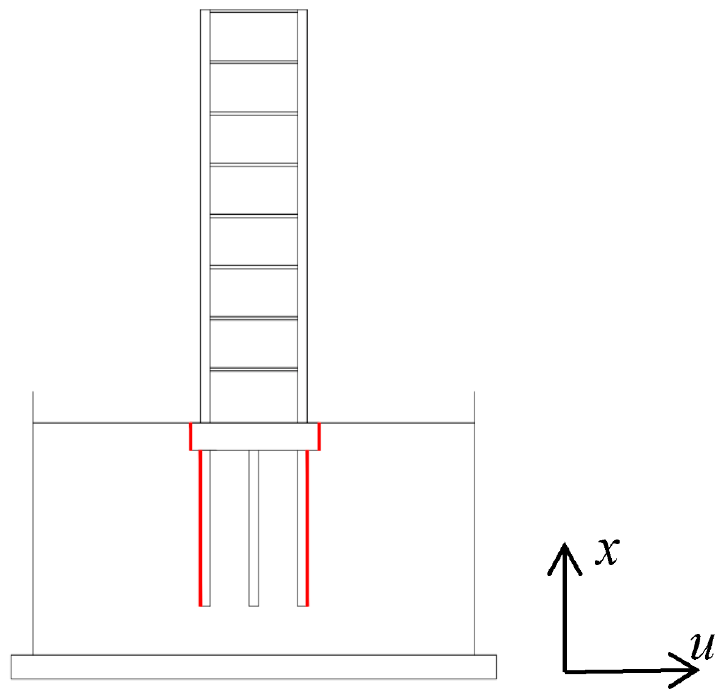
Figure 6. The schematic diagram of the interface of soil-structure interaction.